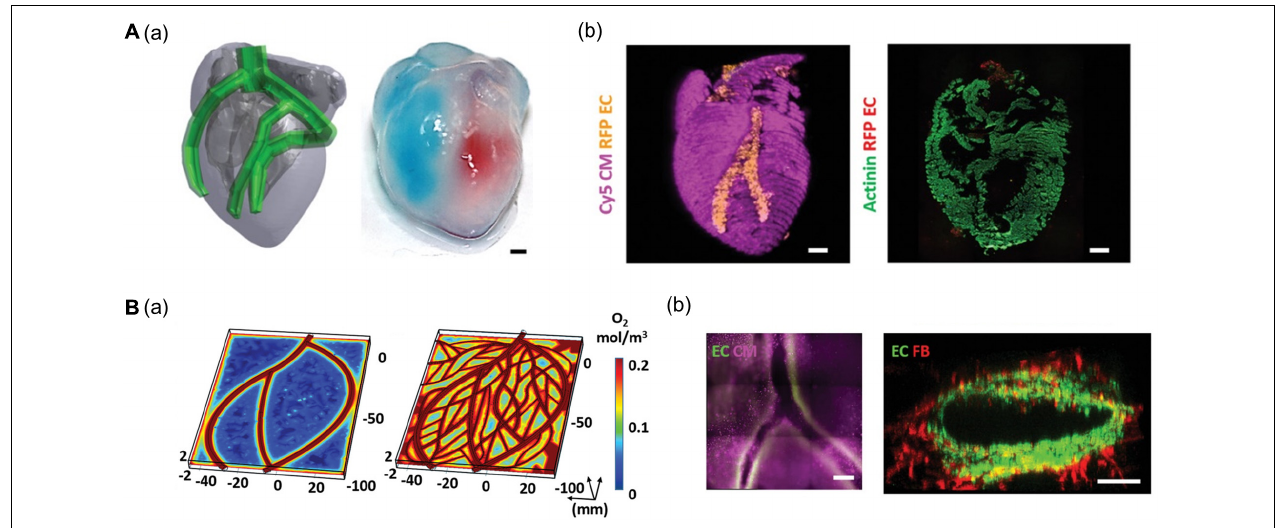
FIGURE 2 | (A) Representative images of cardiac models composed of chamber and major vessel. (a) CAD design and printed structure of the cardiac chamber show the compartment of the left and right ventricle. (b) Confocal image of printed cardiac chamber indicates the spatial organization of CM (pink) and EC (orange) and cross-sectioned immunostaining showed internal compartmented CM (green) and EC (red) structure. (B) Characteristic of coronary artery network. (a) Supplemented blood vessels of coronary artery network exhibit improved oxygen diffusion via oxygen concentration profiles. (b) Immunofluorescence images show the branching and lumen structure of the coronary artery structure. Reprinted with permission from Noor et al.